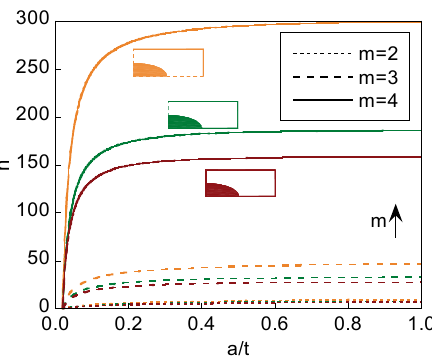
Figure 8. Dimensionless number of cycles for the preferential crack paths. (The arrows indicate the direction in which the curves are moved with the increase of the Paris m exponent).